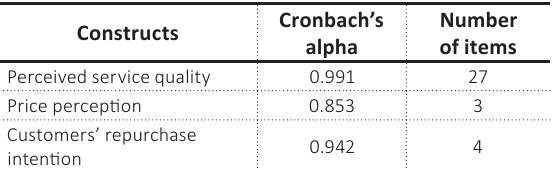
Table 3. Reliability test